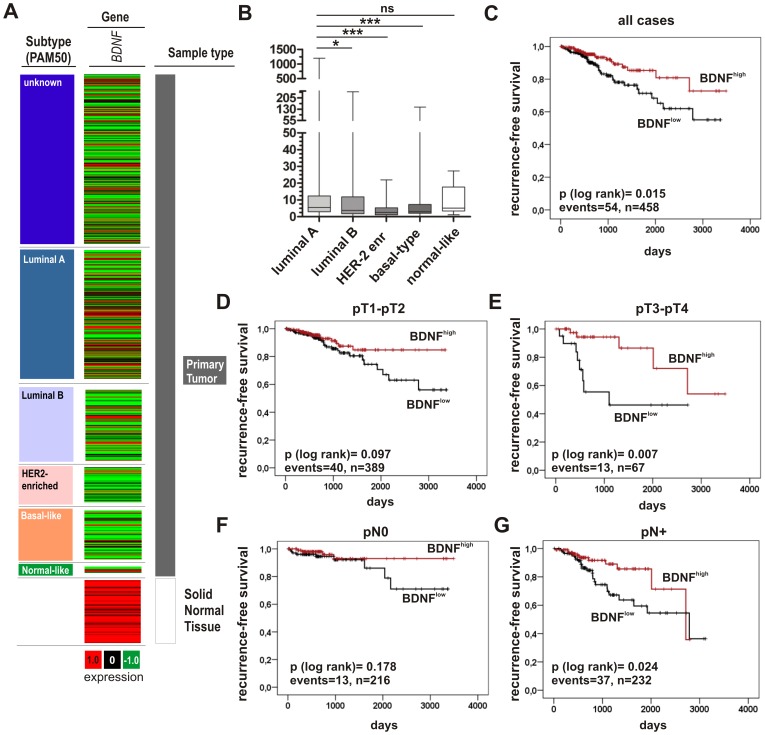

BDNF gene expression is associated with longer recurrence-free survival in human breast cancer of public TCGA data sets [17].(A) BDNF expression in breast tumor samples. Red: high expression, black: mean expression and green: low expression. Left panel: clinical data. Middle panel: BDNF mRNA expression. Right panel: sample type (dark grey: primary tumor; white: solid normal tissues; based on TCGA Ilumina platform, n = 1032 samples). (B) BDNF expression in relation to tumors stratified by subtypes [23]. ns: not significant, *p<0.05, ***p<0.001. (C–G) Kaplan-Meier analysis of the TCGA data set illustrating RFS of patients with high BDNF (red curve) compared to reduced BDNF expression (black curve) in (C) all, (D) pT1-pT2 (E) pT3-pT4 (F) nodal-negative (pN0) or (G) nodal-postive (pN+) breast cancer patients. Vertical lines: censored cases.